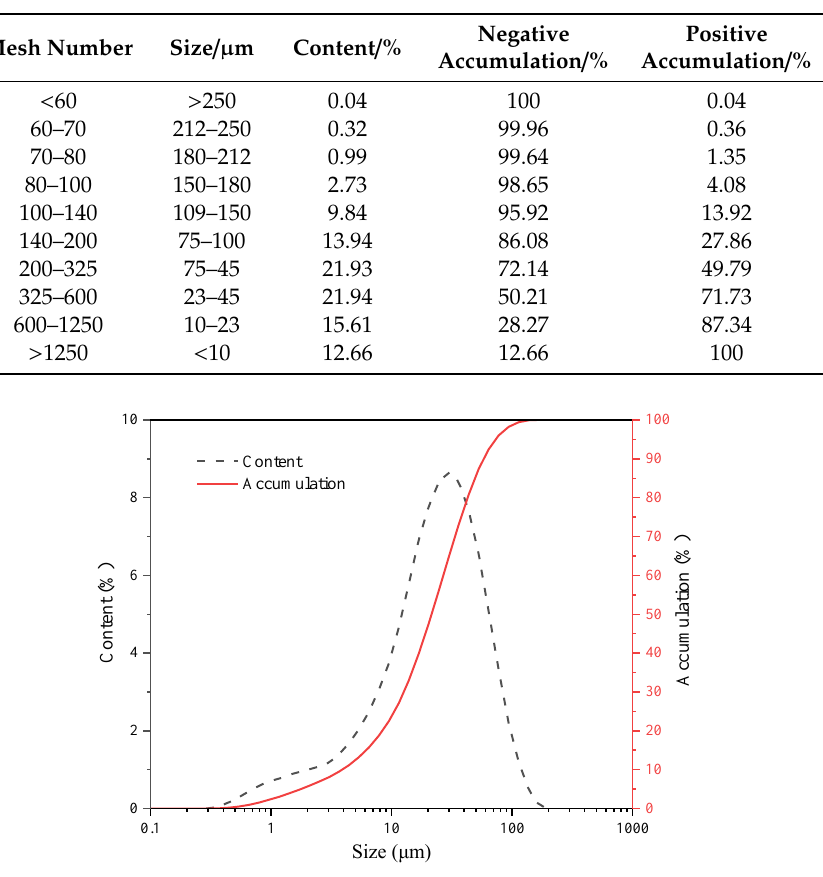
Table 1. Particle size composition of test material.